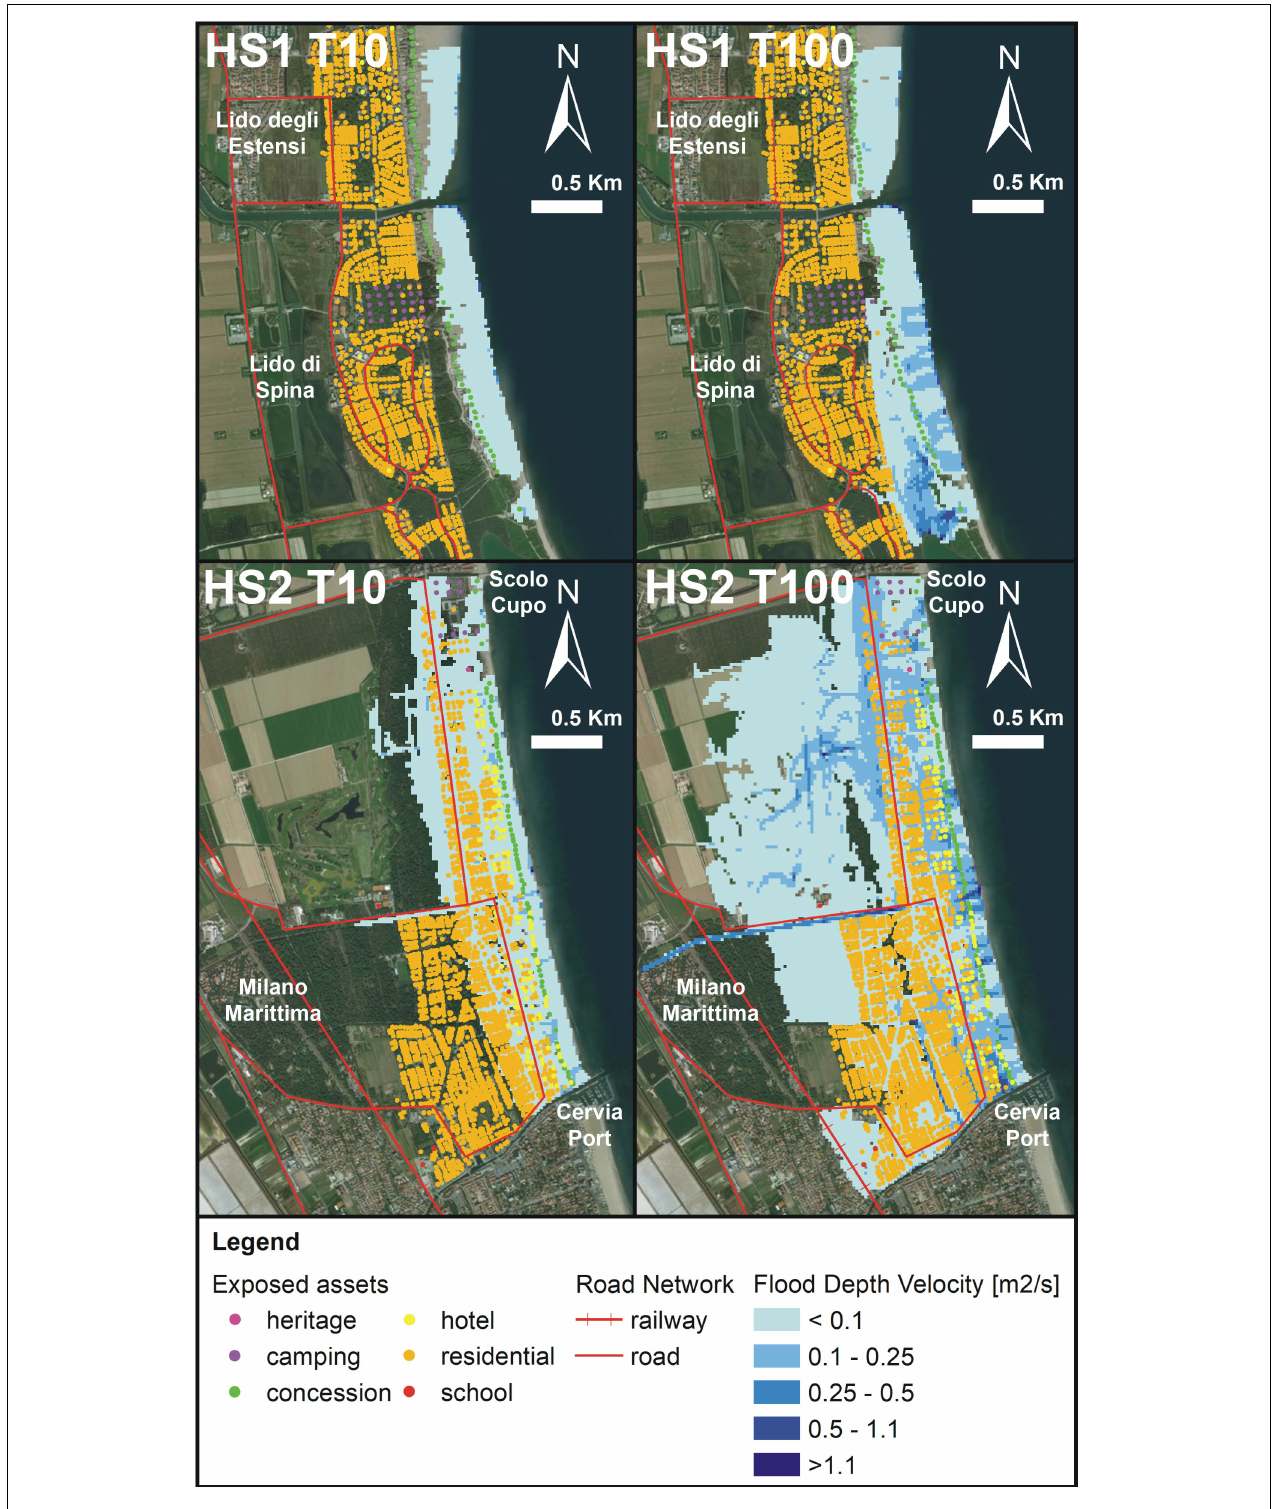
FIGURE 6 | Identified assets and transport network in the two selected hotspots (HS1, Lido degli Estensi-Lido di Spina; HS2, Milano Marittima) and flooding extension. Flood depth-velocity calculated through the hazard modeling chain presented in Figure 2 for the two selected storms (T10 and T100) in the two hotspots: HS1, upper figures; HS2, lower figures. The selected classes for the visualization of flood depth-velocity values are chosen on the basis of the risk to life matrix and also presented in Table 5 .